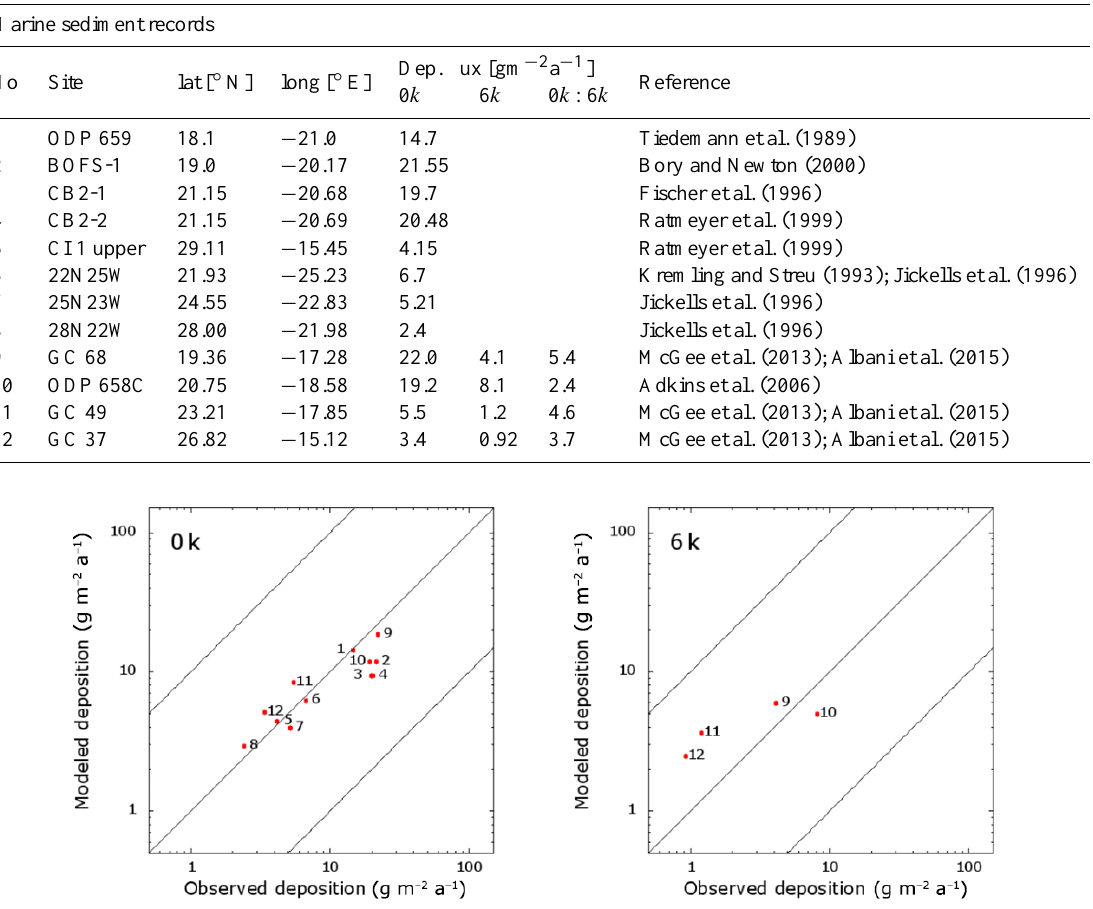
Table 4. Position, dust deposition fluxes for 0 k and 6 k and the corresponding flux ratio between 0 k and 6 k obtained from marine sediment cores (1, 9, 10, 11, 12) and sediment traps (2, 3, 4, 5, 6, 7, 8) close to the northwest African margin.